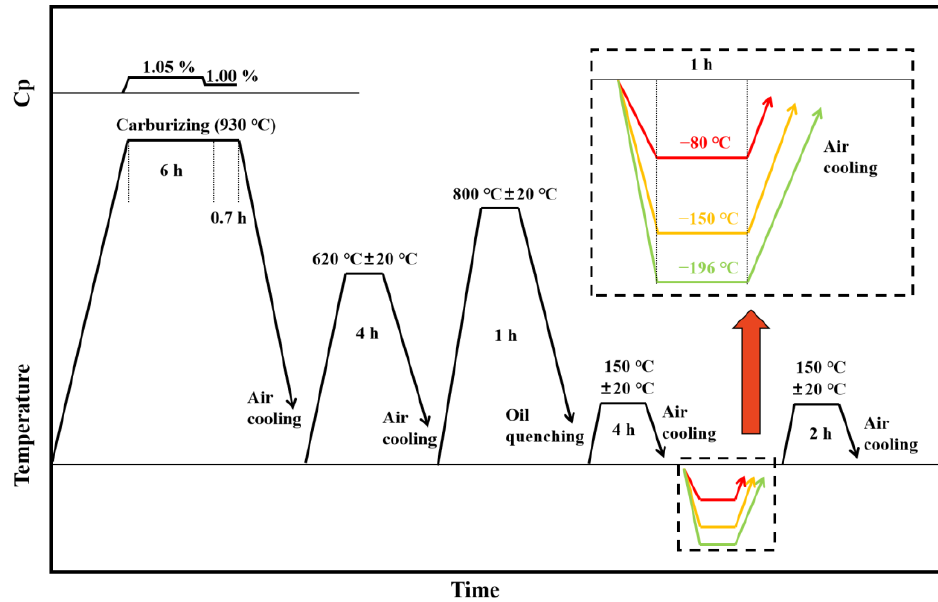
Figure 1. Schematic illustration of the carburizing and heat treatment processes of the experimental steel. Cp denotes the carbon potential during the carburizing process.